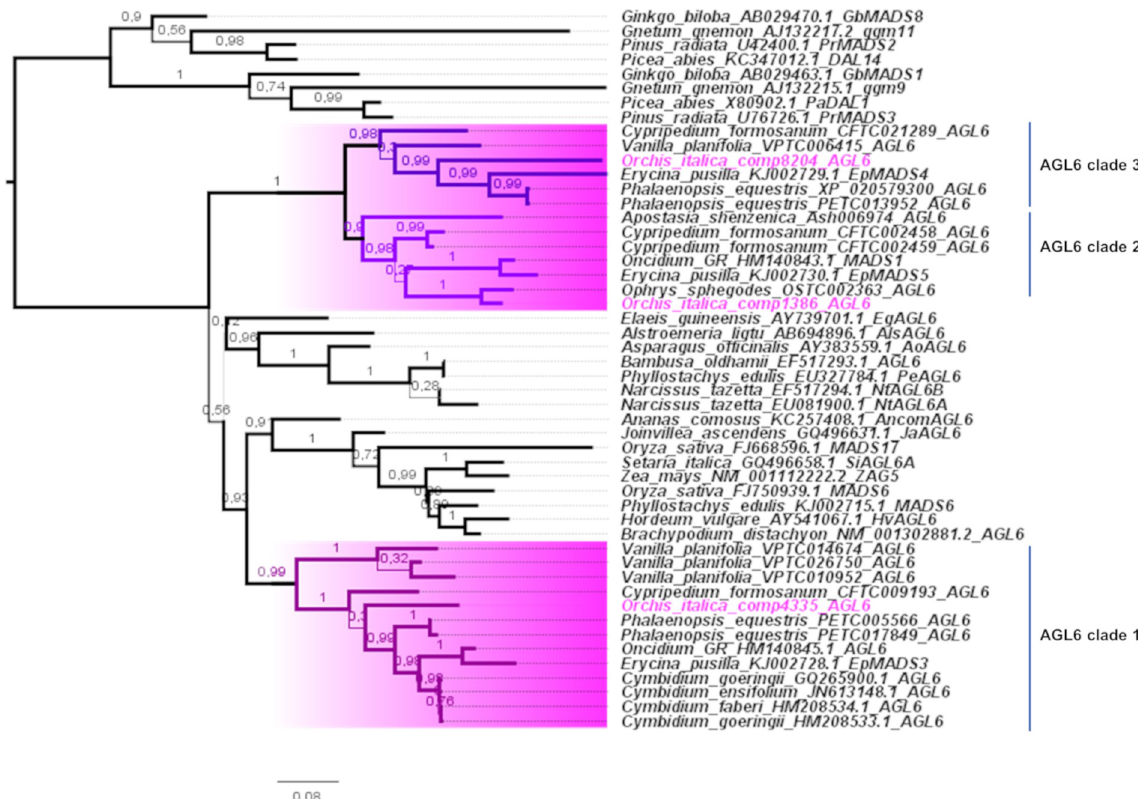
Fig 6. ML tree of the AGL6 MADS-box proteins. The orchid branches are highlighted in pink, and the orchid AGL6 clades 1–3 are indicated. The accessions of O . italica are noted in pink. The numbers indicate the statistical support of the branches.